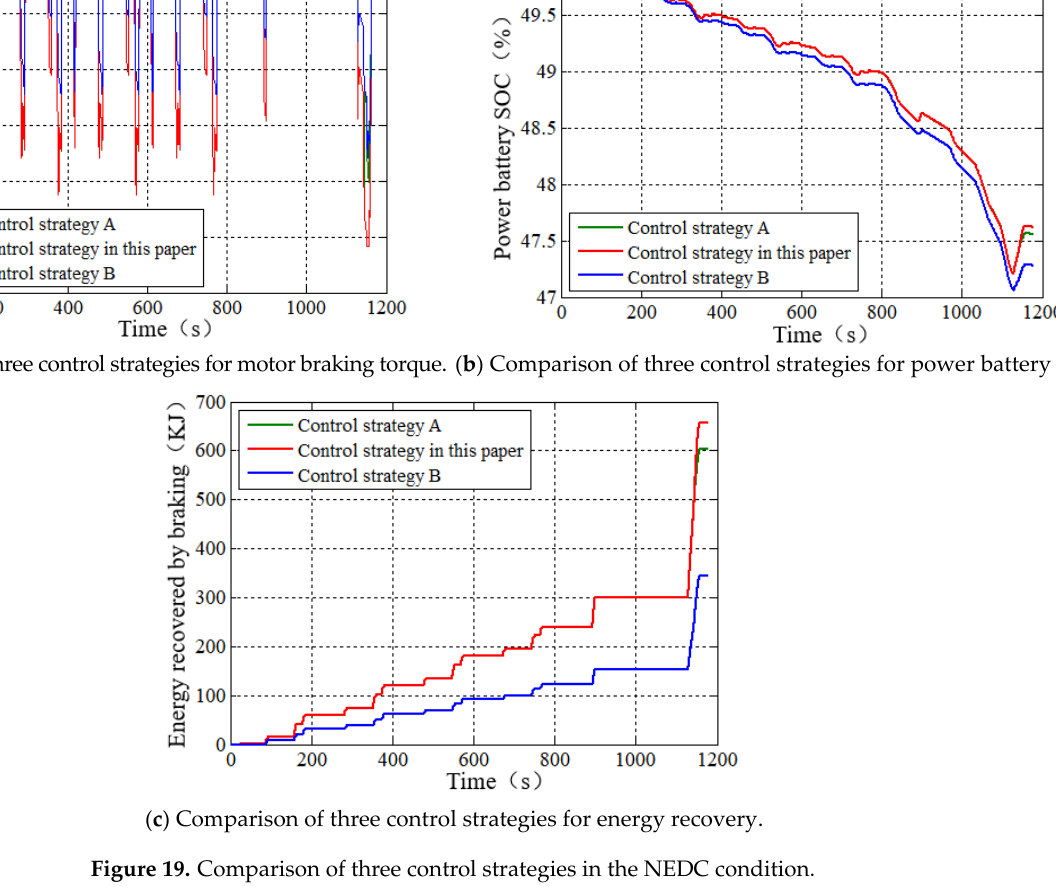
Figure 19. Comparison of three control strategies in the NEDC condition. (2) WLTC